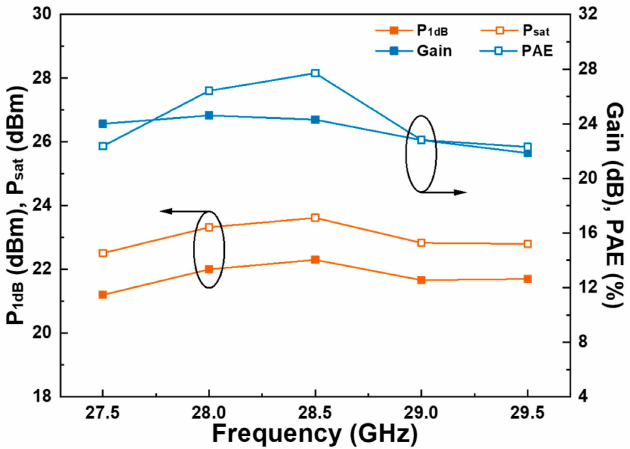
Figure 15. Measurement results: P 1dB , P sat , gain, and PAE according to the frequency.